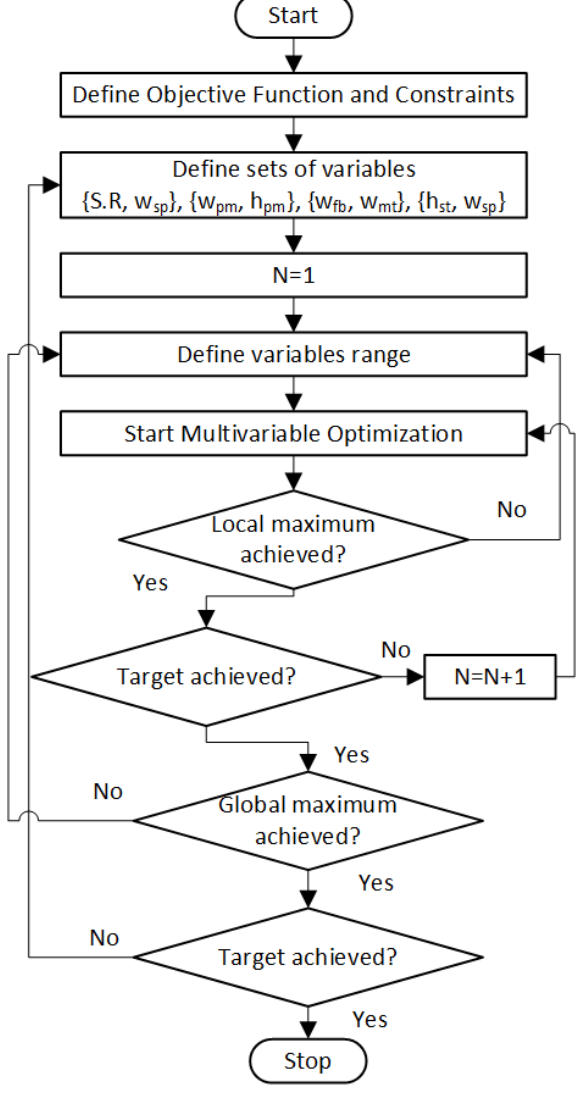
Figure 7. Flow chart for